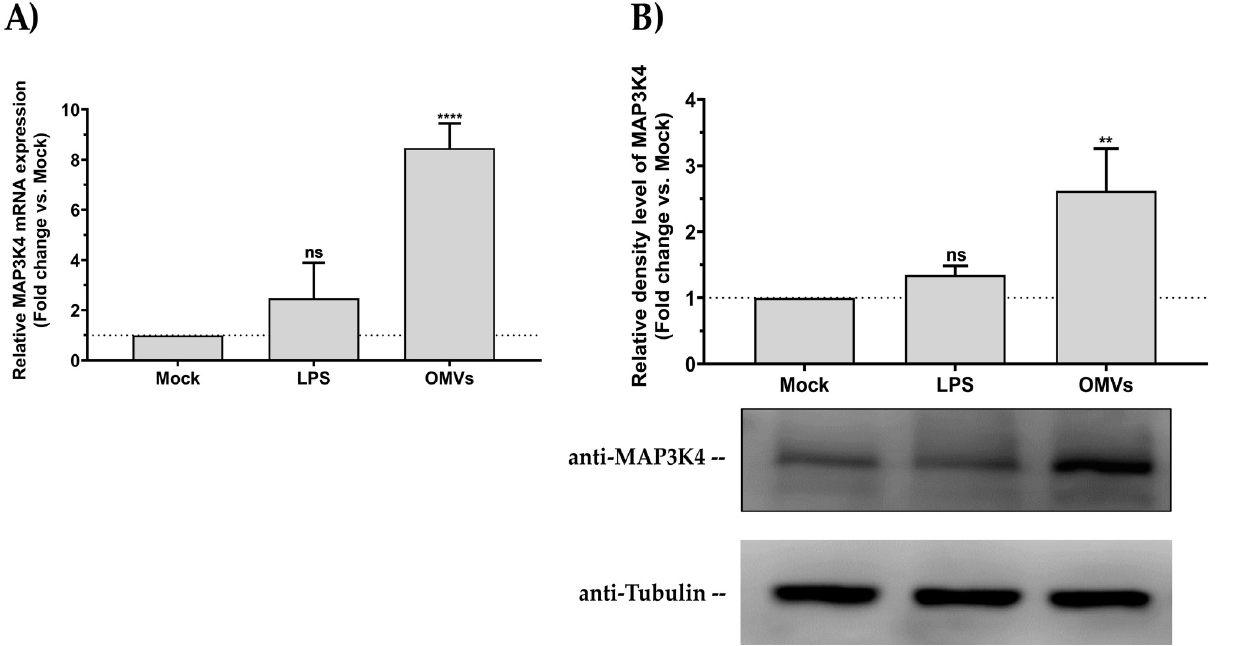
Fig 7. Bacterial OMVs enhance human MAP3K4 expression. Human HCT116 cells were incubated with (10 ng) E . coli MG1655-derived OMVs or an equivalent amount of LPS, compared to a mock control. ( A ) Relative quantification of MAP3K4 mRNA expression by RT-qPCR. Data were normalized with a reference gene (ACTB), reported as fold change vs mock control, and expressed with the relative quantitation method ( ΔΔ Ct). ( B ) Western blot analysis of MAP3K4 protein expression relative to tubulin. Densitometric analysis of the bands was performed with ImageJ. Data were normalized with a reference gene (tubulin) and expressed as fold change vs mock control. Statistical analysis. Data were calculated from three biological replicate measurements (n = 3; mean ± SD). One-way analysis of variance (ANOVA) and Holm-Sˇı´da´k’s multiple comparisons test (post-hoc test) were used for statistical analysis. Statistically significant differences (fold change vs mock) are indicated as follows: �� p < 0.01; ���� p < 0.0001. ns, not significant.